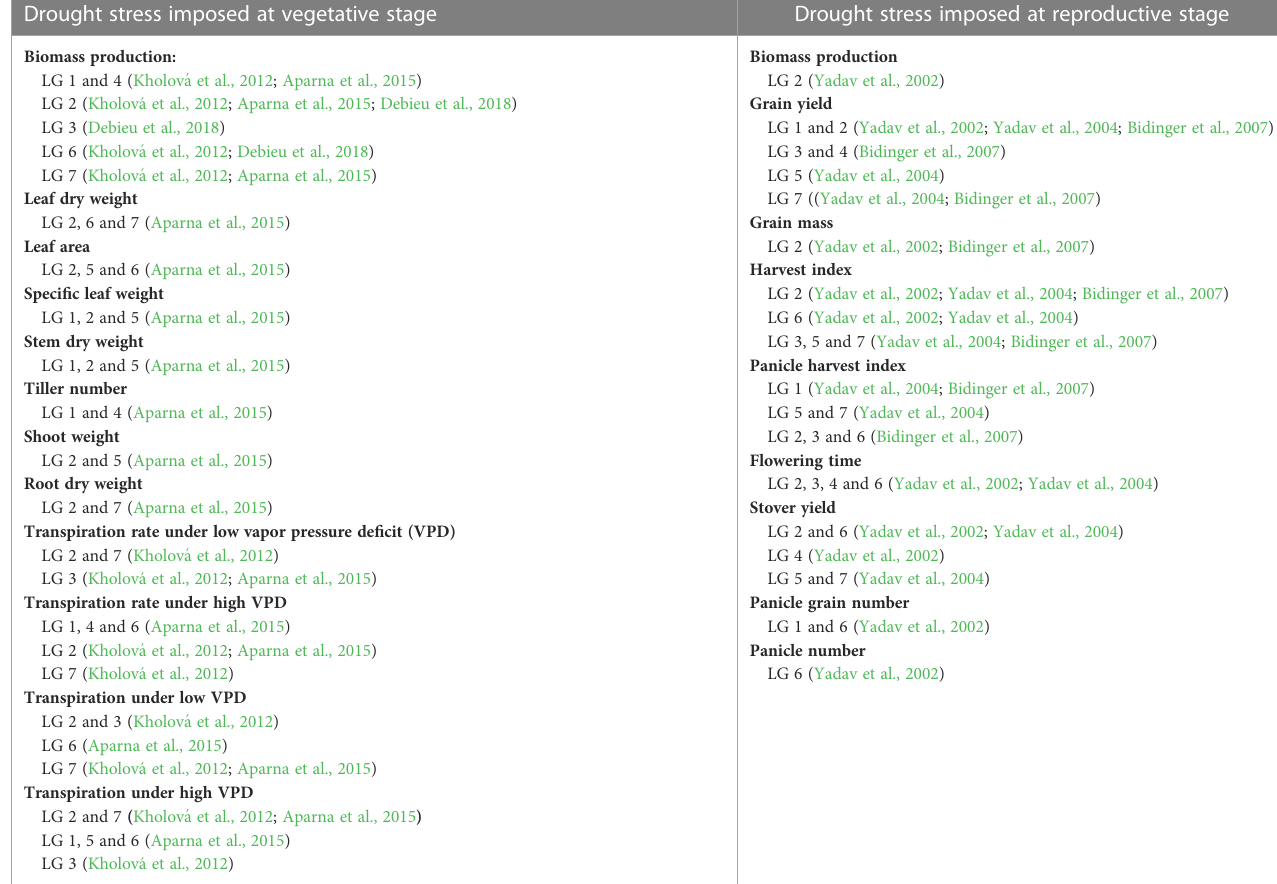
TABLE 1 Summary of QTLs identi fi ed associated with yield component traits during drought stress caused at various stages of growth period across the seven linkage groups from various studies. Drought stress imposed at vegetative stage Drought stress imposed at reproductive